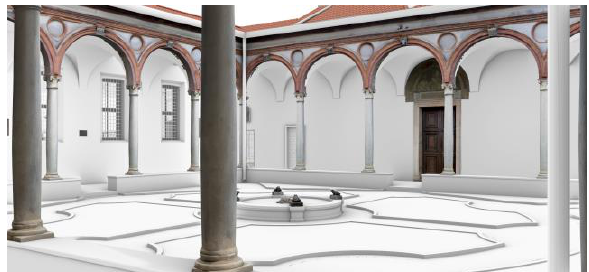
Figure 7. Complete 3D model of the Cloister of the Frogs. The coloured elements are the ones obtained in the form of textured meshes, the white elements are the ones modelled on Rhinoceros as NURBS.